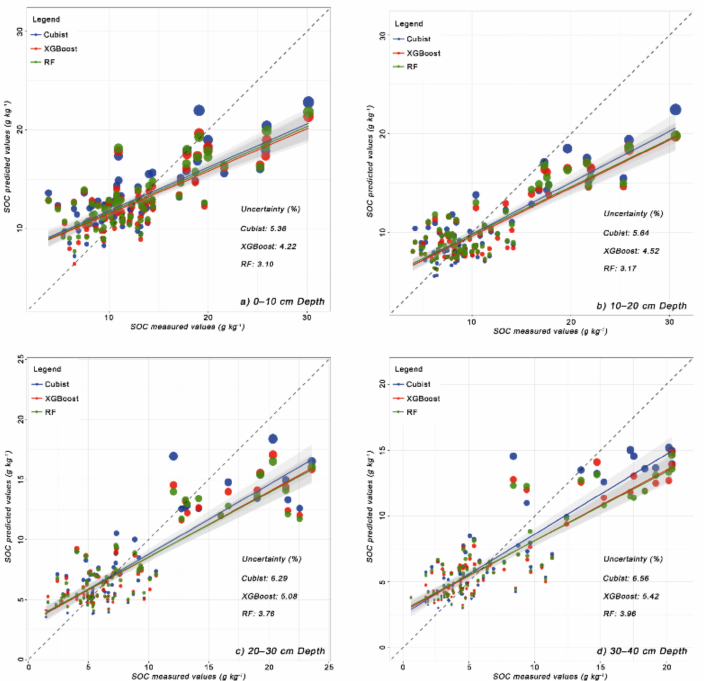
Figure 4. Scatter plot of SOC predicted values and SOC measured values with Cubist, XGBoost and RF in ( a ) 0–10 cm depth, ( b ) 10–20 cm depth, ( c ) 20–30 cm depth and ( d ) 30–40 cm depth, where the point size is the uncertainty of the sampling